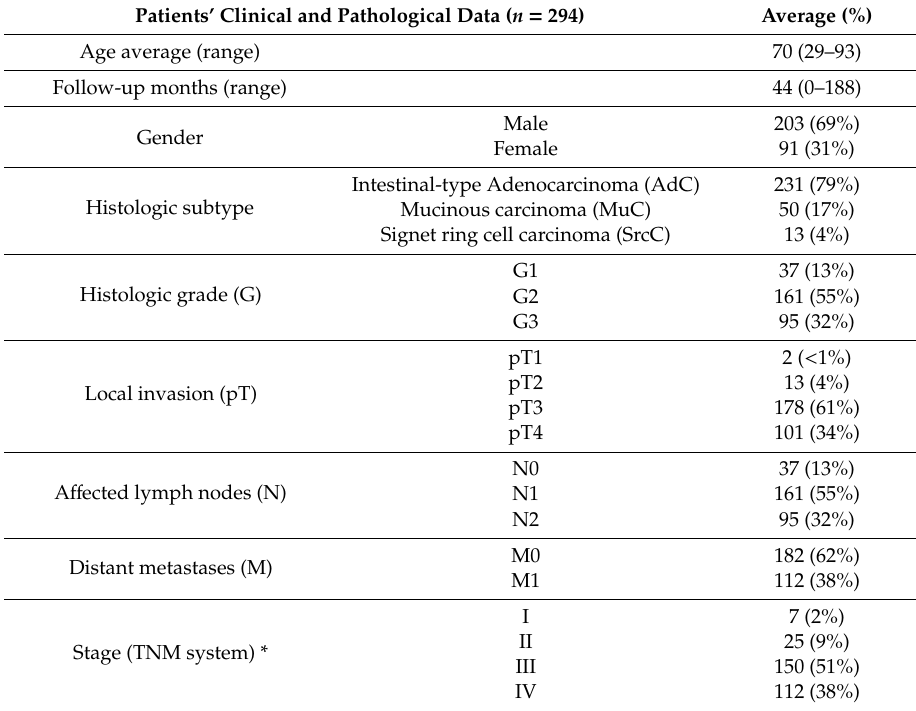
Table 1. Clinical and pathological parameters of the colorectal cancer (CRC) patients’ tissues used for (pro)renin receptor (PRR) immunohistochemical